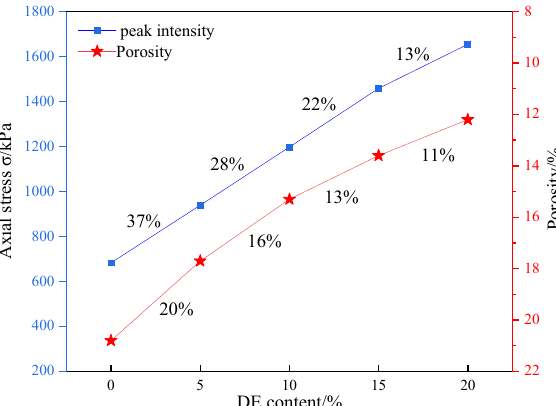
Figure 11. Relationship between the porosity and strength of diatomite-modified coastal cement soil; the intensity or porosity of diatomite varied from one dosage to the next.